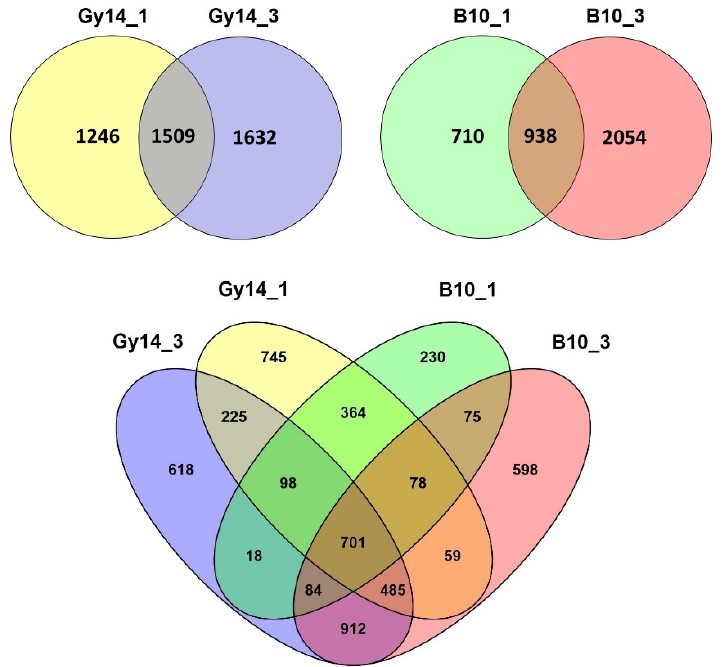
Figure 4. Venn diagrams representing the distribution of differentially expressed genes (DEGs) in the resistant Gy14 line and susceptible B10 line at 1 and 3 dpi with Psl 814/98. Abbreviations: B10_1–B10 line at 1 dpi, B10_3–B10 line at 3 dpi, Gy14_1–Gy14 line at 1 dpi, Gy14_3–Gy14 line at 3 dpi.